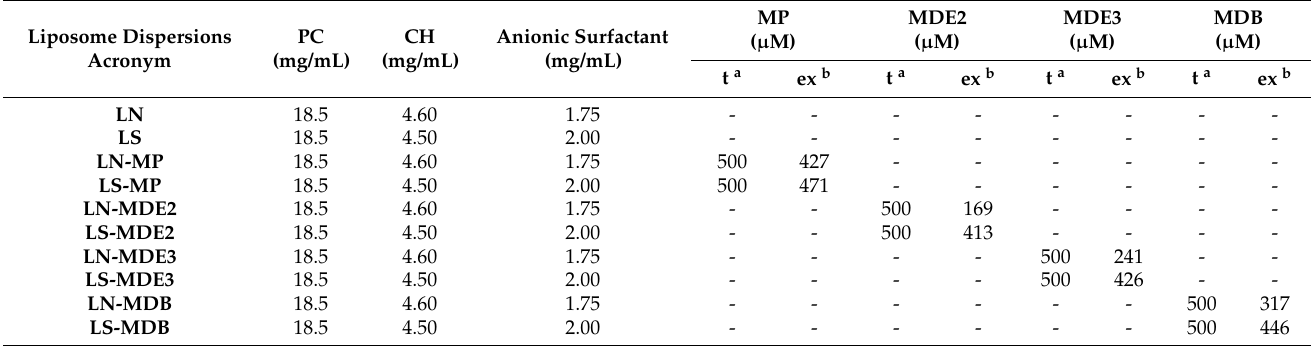
Table 2. Composition of the liposomal formulations considered in the present